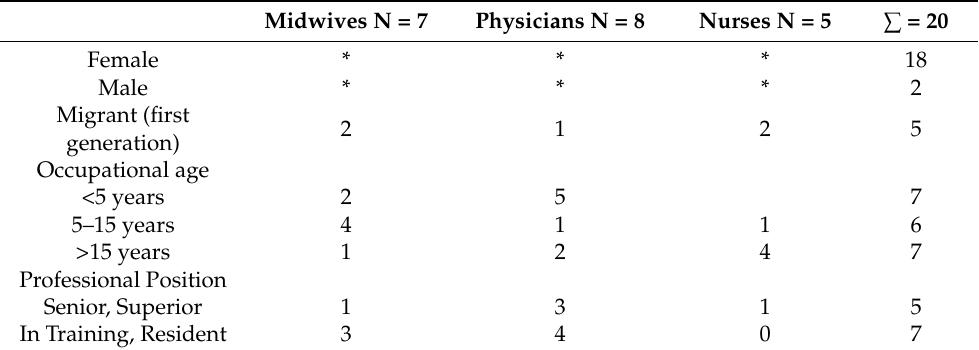
Table 2. Demographic characteristics (no numbers for gender among the profession are displayed due to data protection